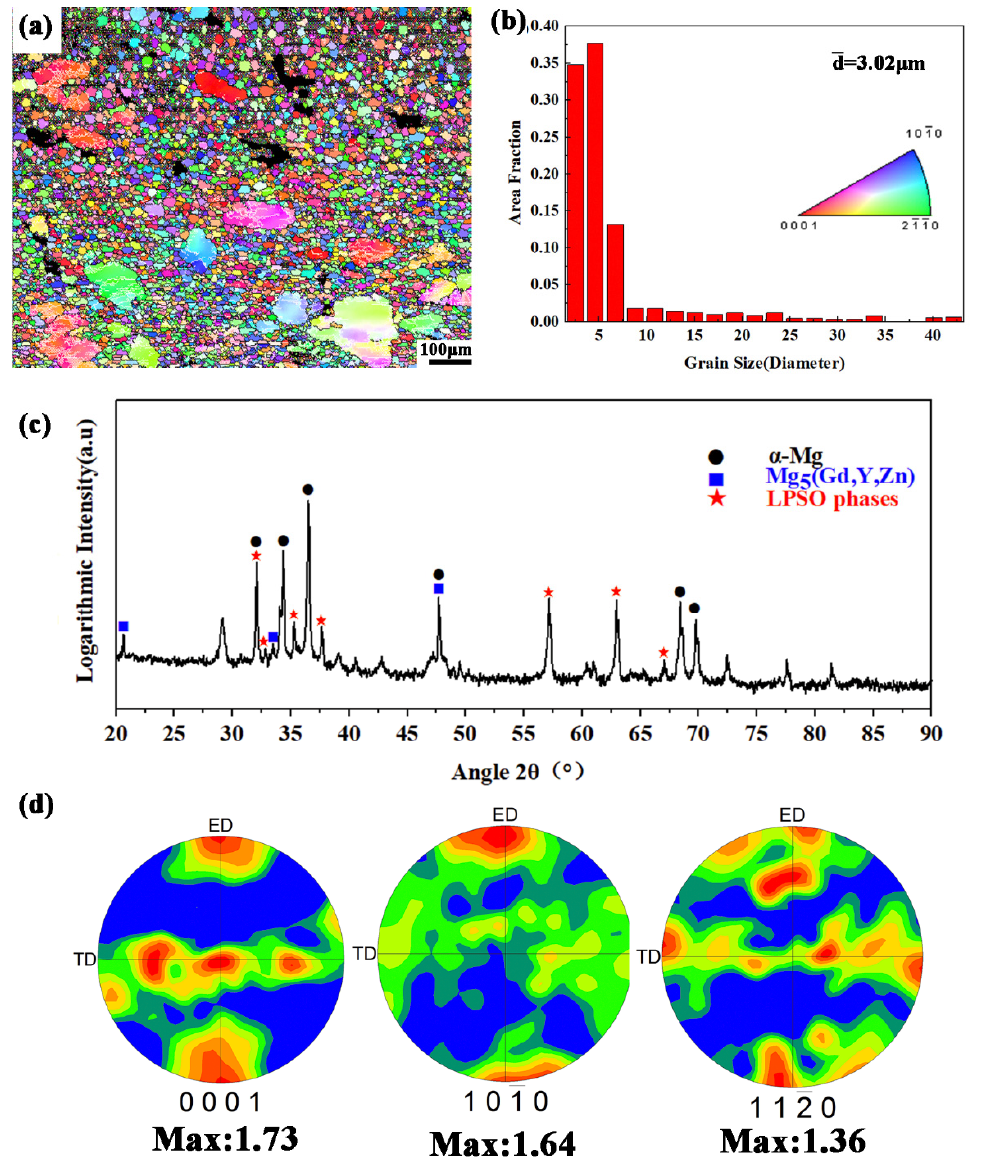
Figure 3. Microstructure of initial Mg-13Gd-4Y-2Zn-0.4Zr billet: ( a ) EBSD map; ( b ) grain size statistical analysis; ( c ) XRD analysis; ( d ) Pole figure analysis.